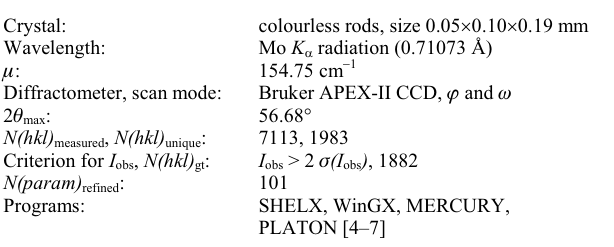
Table 1. Data collection and